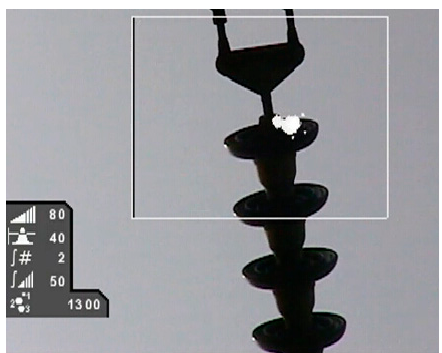
Figure 15. Detection image of Type B in the on-site test. Table 8. Photon numbers of Type B in the on-site test.